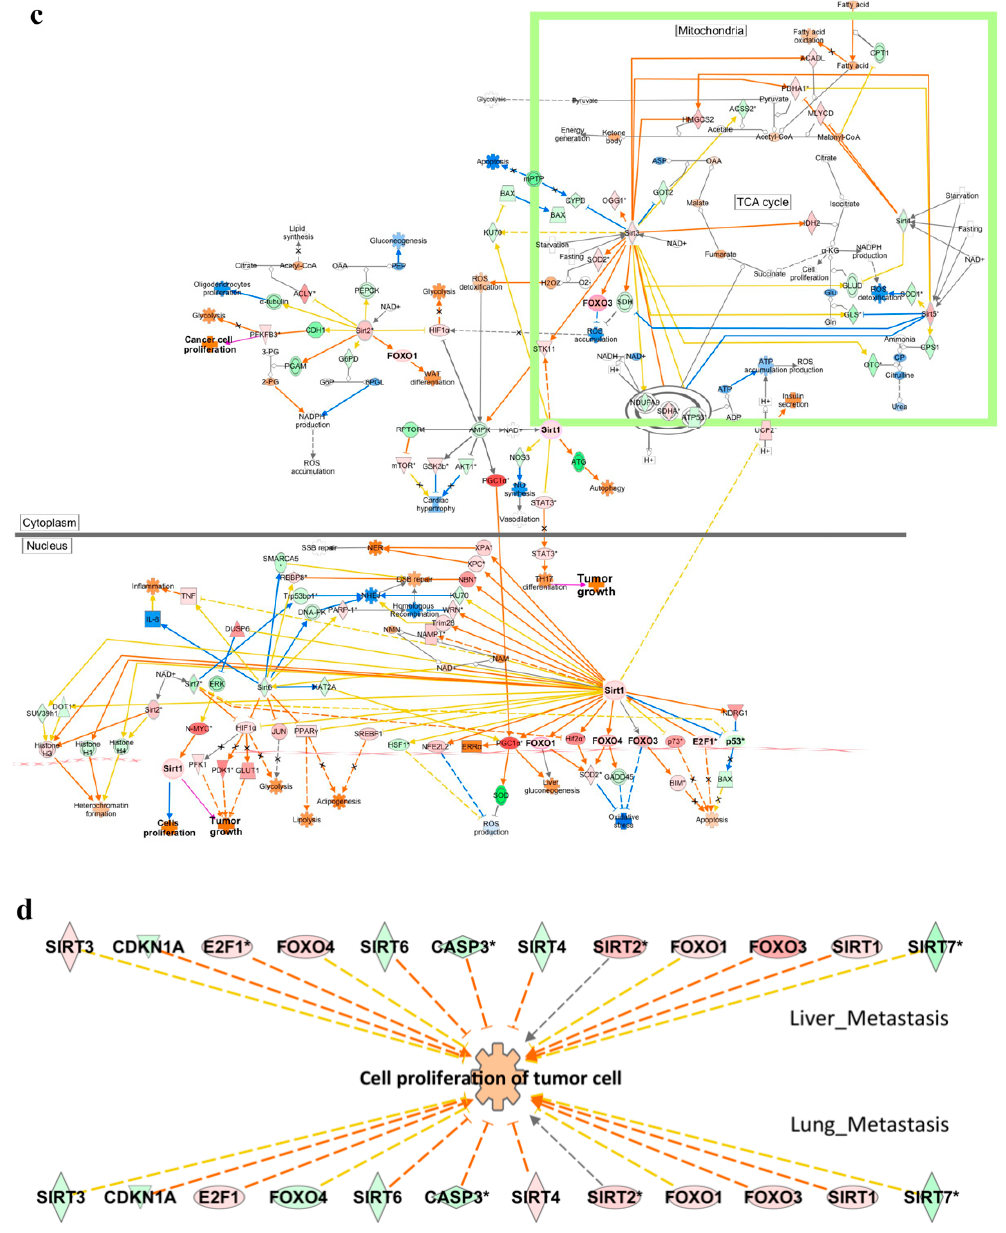
Figure 5. Canonical pathway comparison of 4T1 primary tumor and metastatic subpopulations by IPA with GSE62598 data. Heat maps show ( a ) activation score (absolute z-score > 2) and ( b ) p value absolute log p -value > 1.3. ( c ) Sirtuin pathway was generated from GSE62598 data that include the gene expression profile of 4T1 primary tumors and liver/lung metastatic subpopulations in a mouse model. The figure represents gene profiling in liver metastasis of 4T1 cells (absolute log p -value > 1.3). ( d ) Cell proliferation of tumor cells was found to have a regulator effect in liver and lung metastases of 4T1 cells by IPA. The intensity of the node color indicated the degree of regulation (red; upregulation, green; downregulation).